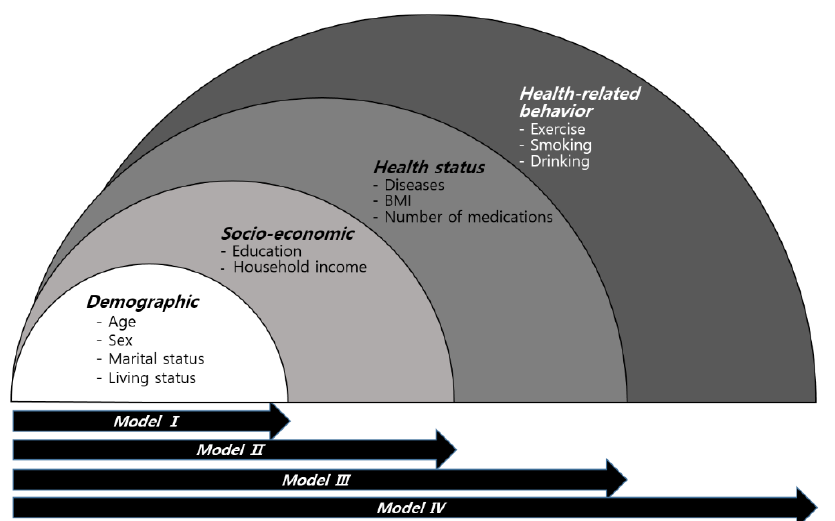
Figure 2. Proposed individual variables-adjusted models. The variables from individual subcate- gories (demographic, socioeconomic, health status, and health-related behavior) were merged in consecutive order and four experimental models were established.